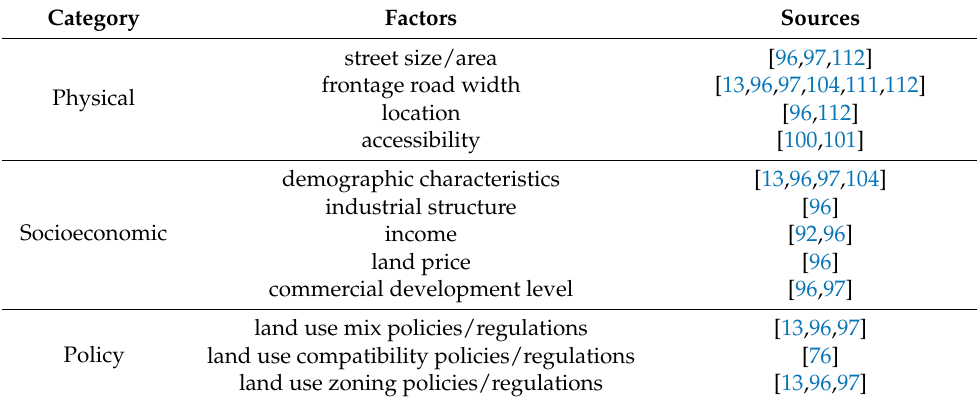
Table 3. Influential factors of land use